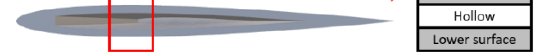
Figure 9. Finite element model ( left ) and cross-section description of a hollow element ( right ).